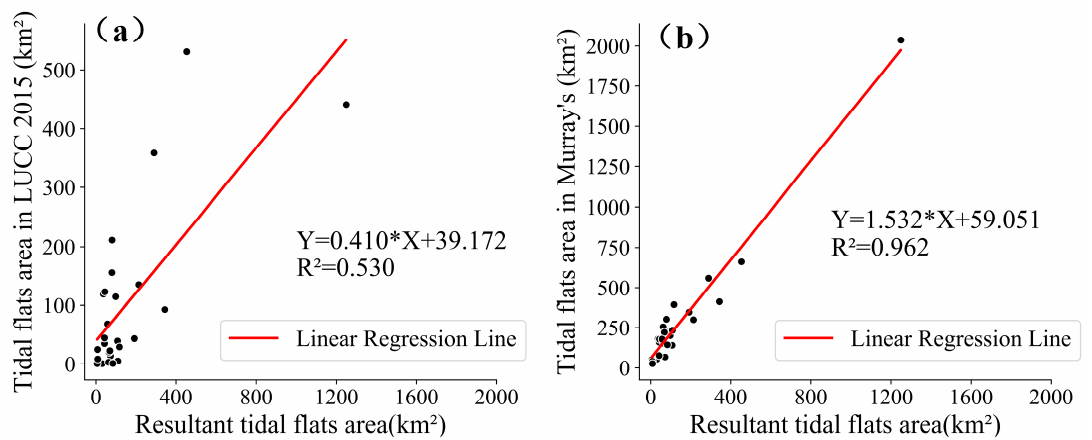
Figure 10. Scatter plot and regression line between our tidal flat map and (a) LUCC 2015 as well as (b) Murray’s in city level, respectively.